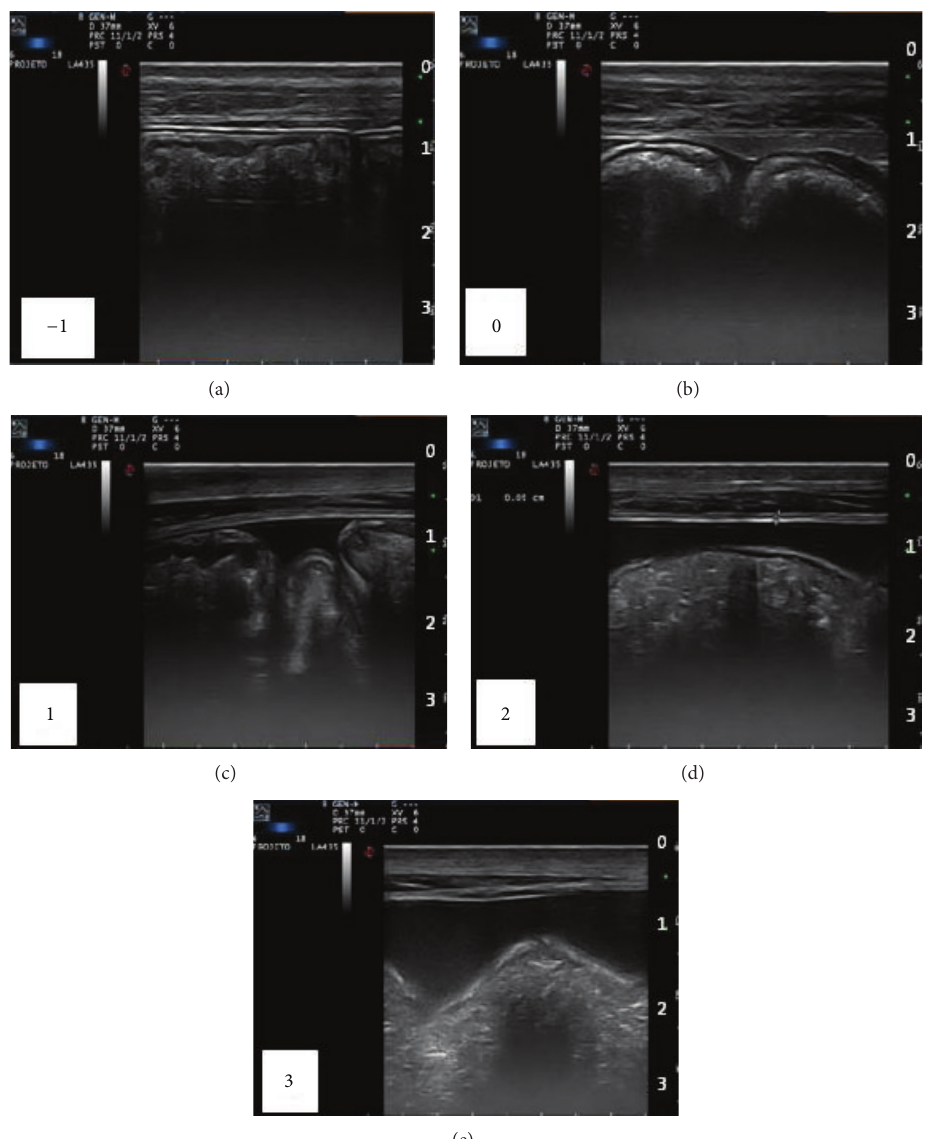
Figure 1: Longitudinal image of the ventral abdomen of horses from both groups, demonstrating the graduation scheme of free peritoneal fluid amount, being − 1 (reduced), 0 (normal), 1 (slightly increased), 2 (moderately increased), and 3 (strongly increased). distance between the peritoneum and the viscera adjacent to the ventral region variated, showing not to be a good evaluation tool to quantify peritoneal fluid. The association of videos findings, notes, and images obtained during ultra- sonography examination was used for